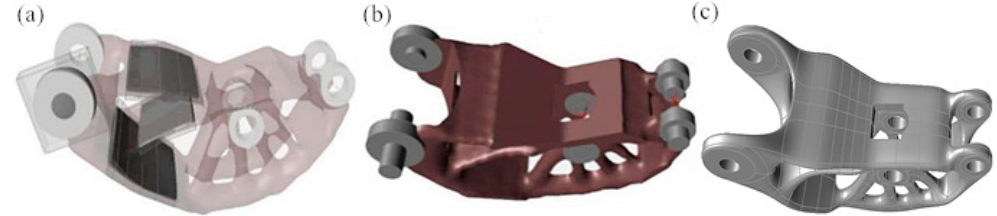
Figure 5. Manual reconstruction: ( a ) Model package; ( b ) Opening of fixed holes; and ( c ) Reconstruction effect.